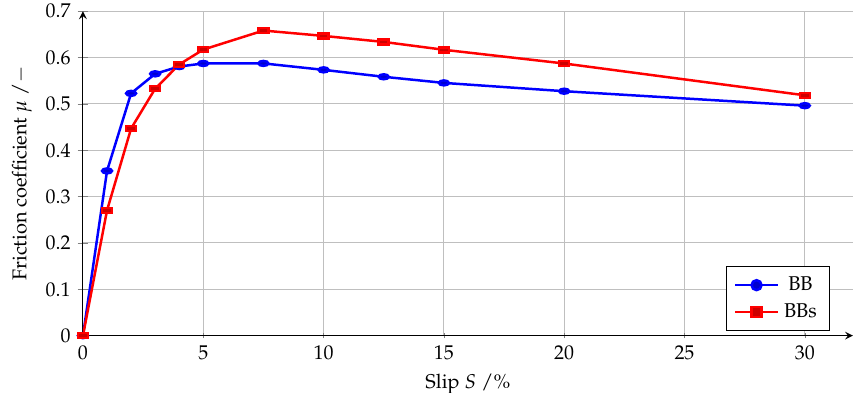
Figure 18. Simulated µ -slip curves for patterns BB and BBs at 140kmh − 1